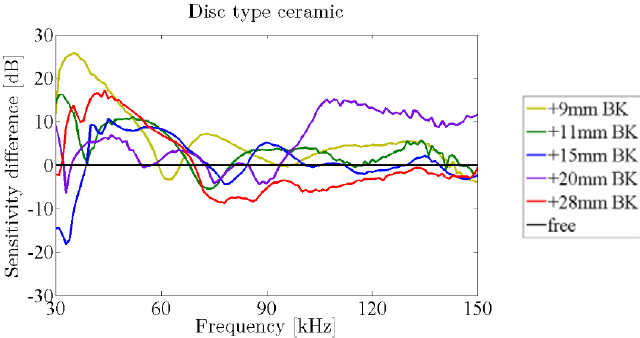
Figure 17. Sensitivity difference of ceramics with backing (color lines) with respect to the one without backing (black line) measured in the water tank.